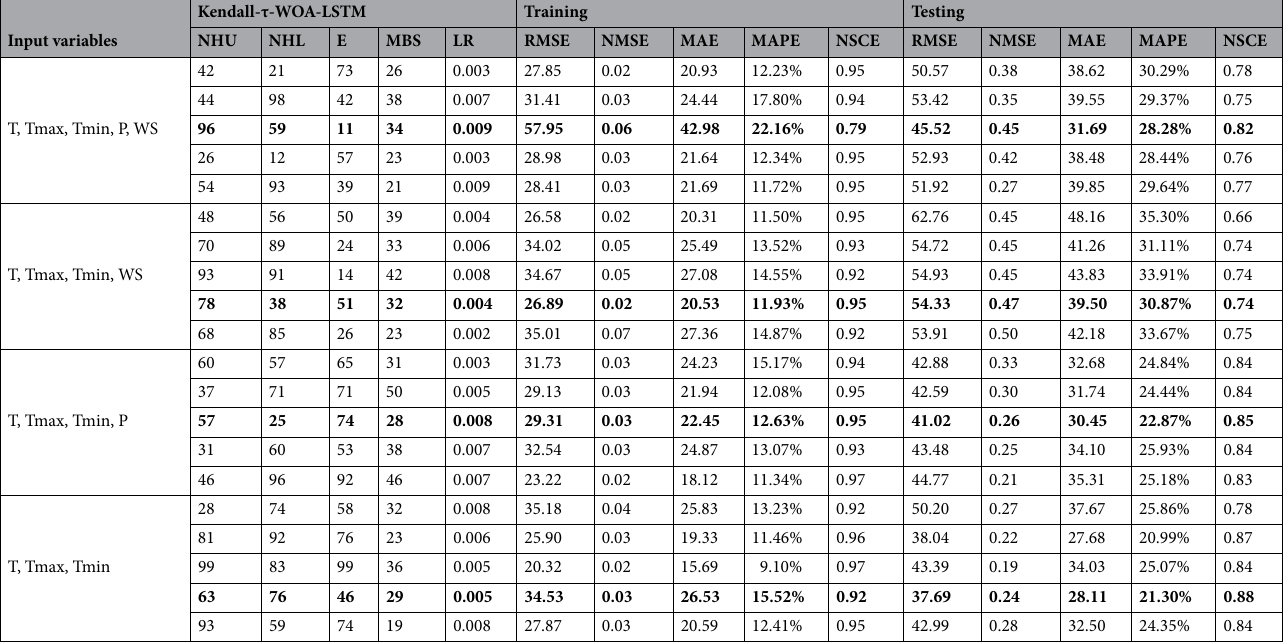
Table 8. The optimal hyper-parameters and model performance of Kendall-τ-WOA-LSTM. The optimal hyper-parameters and evaluation metrics of the hybrid Kendall-τ-WOA-LSTM model are marked in